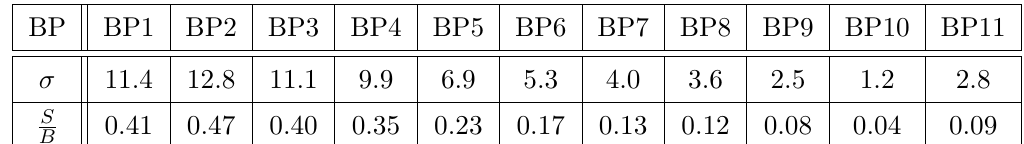
) are shown for the signal B final state at 14 TeV T